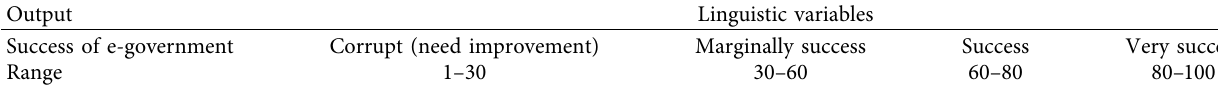
Table 2: Output with its linguistic variable.